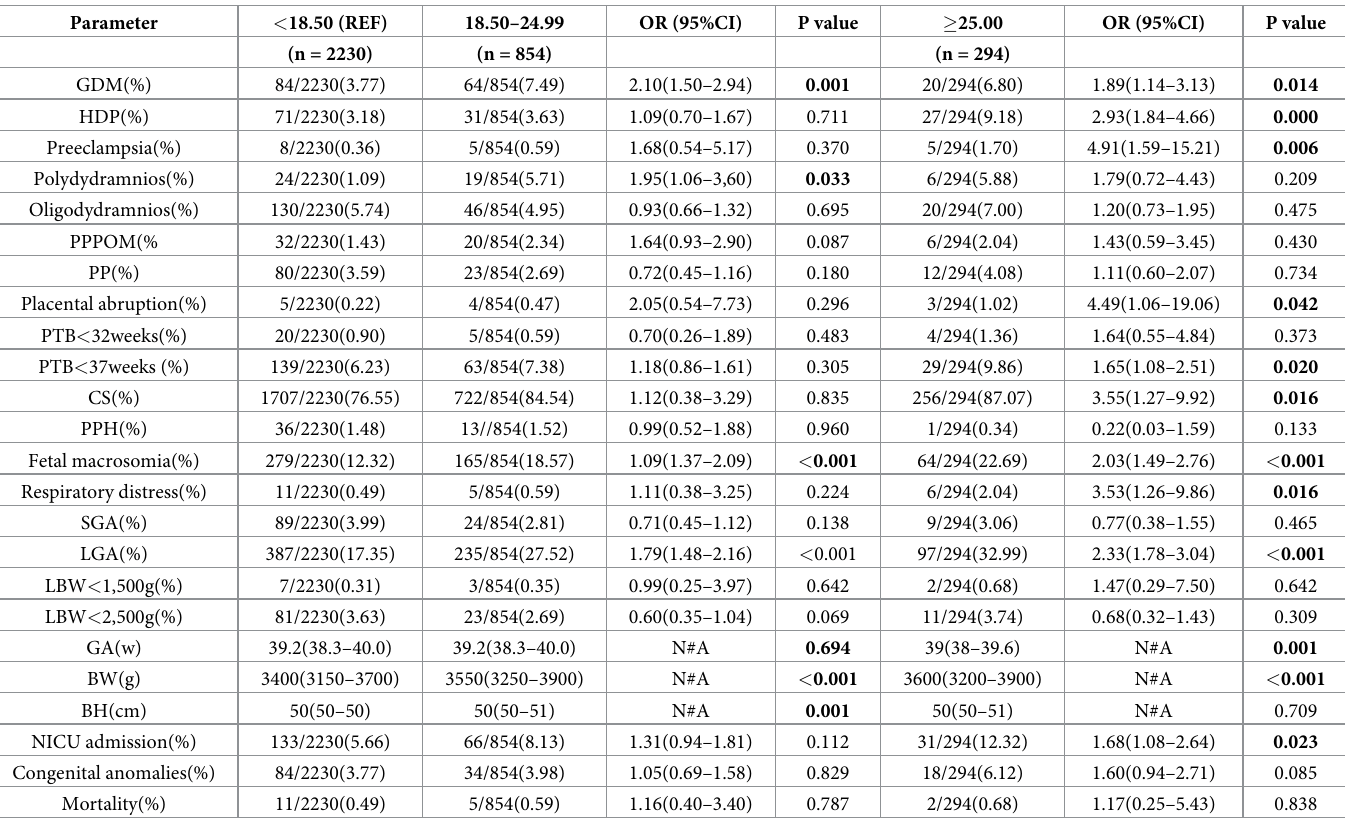
Table 5. Obstetric and neonatal outcomes by BMI category in women without PCOS.